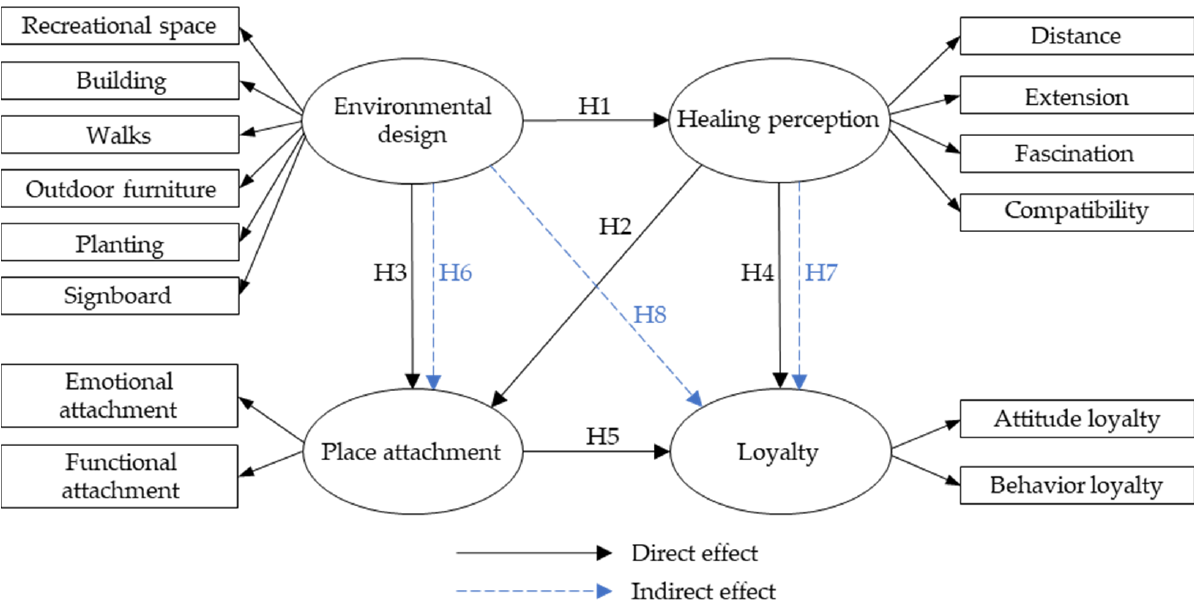
Figure 1. Proposed framework for the research.